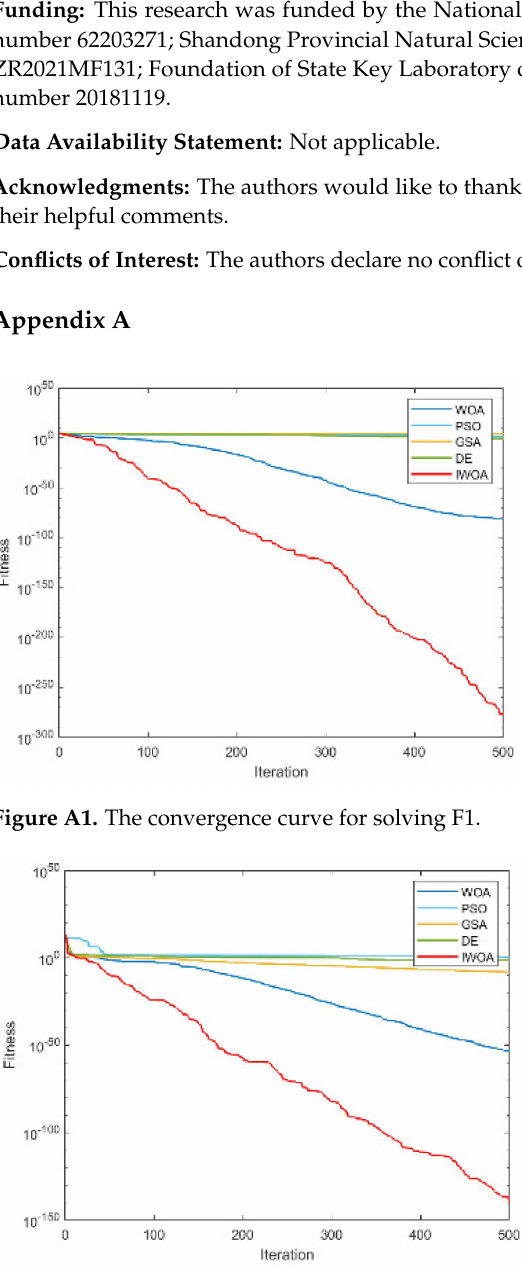
Figure A2. The convergence curve for solving